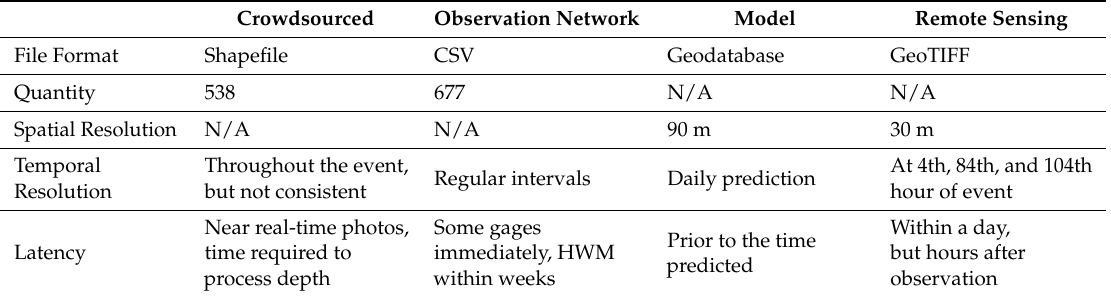
Table 1. Summary of the specified data sources for the study area in relation to Hurricane